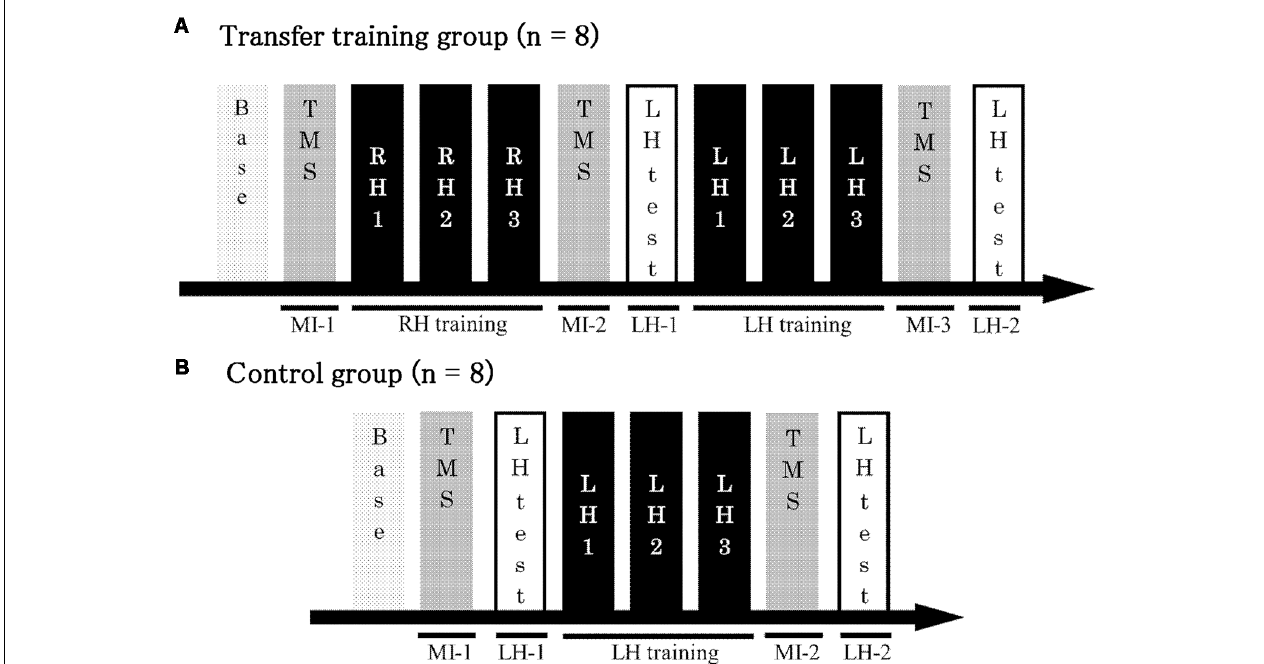
FIGURE 1 | Experimental protocol. (A) The transfer training group trained using both the right and left hands. Test trials were conducted to measure motor potentials evoked by transcranial magnetic stimulation (TMS) during MI at three time points in the training process: before right-hand training, after right-hand training but before left-hand training, and after left-hand training. (B) The control group received only left-hand training. Test trials were conducted to measure motor potentials evoked by TMS during MI at two time points in the training process: before and after training. Base, Baseline; MI, motor imagery; LH, left hand; RH, right hand; LH-1, LH-2, performance of the left